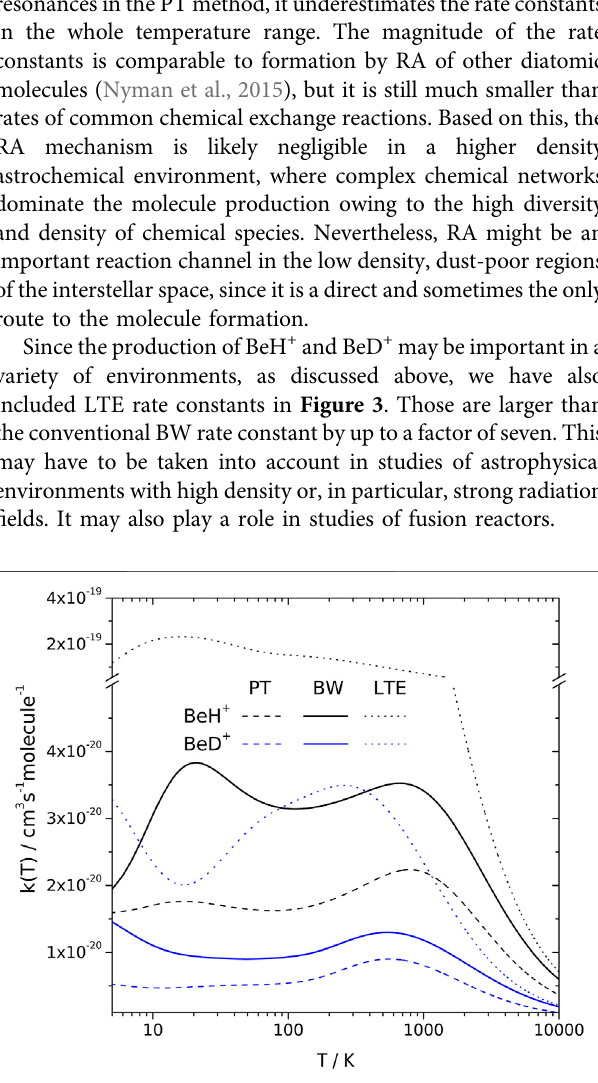
Frontiers in Astronomy and Space Sciences |